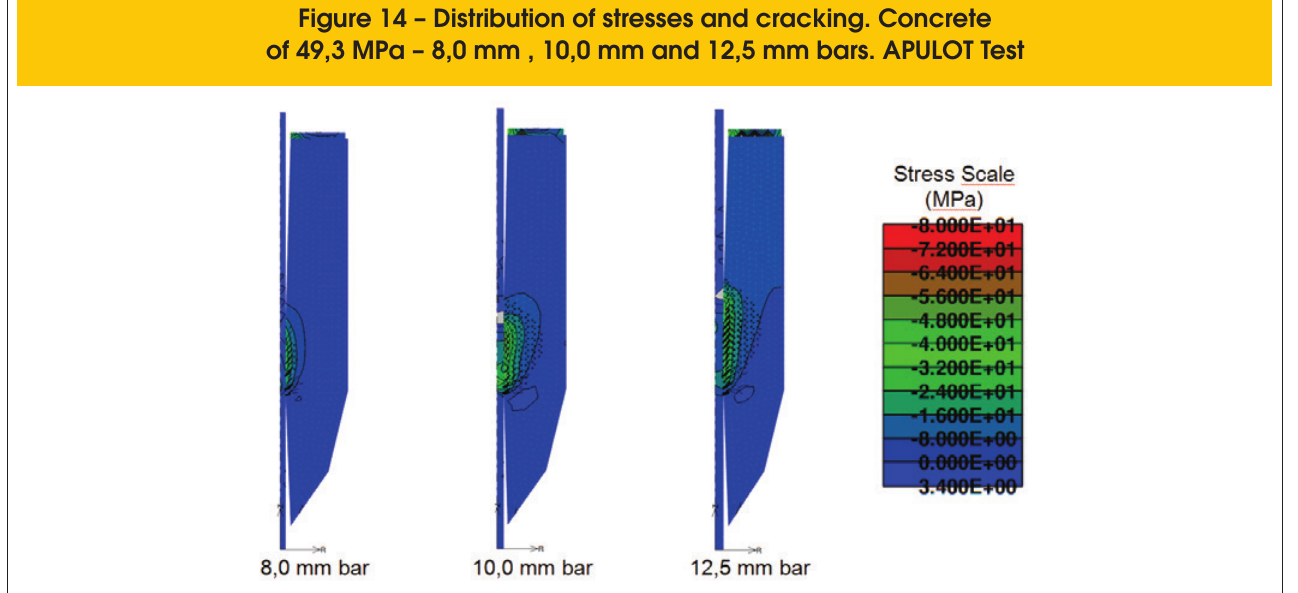
Figure 14 – Distribution of stresses and cracking. Concrete of 49,3 MPa – 8,0 mm , 10,0 mm and 12,5 mm bars. APULOT